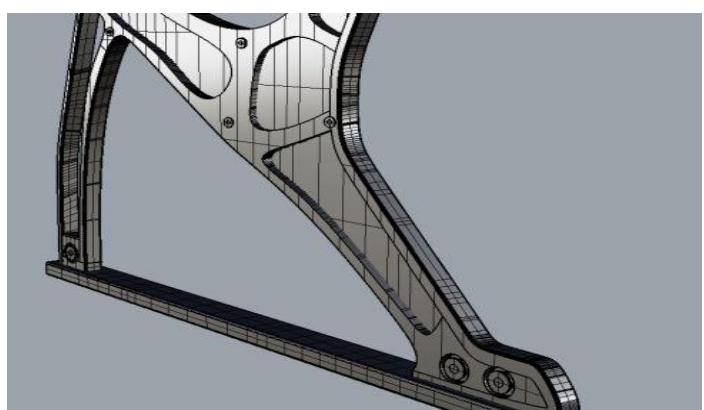
Figure 14. Redesigned structure with reinforced support.